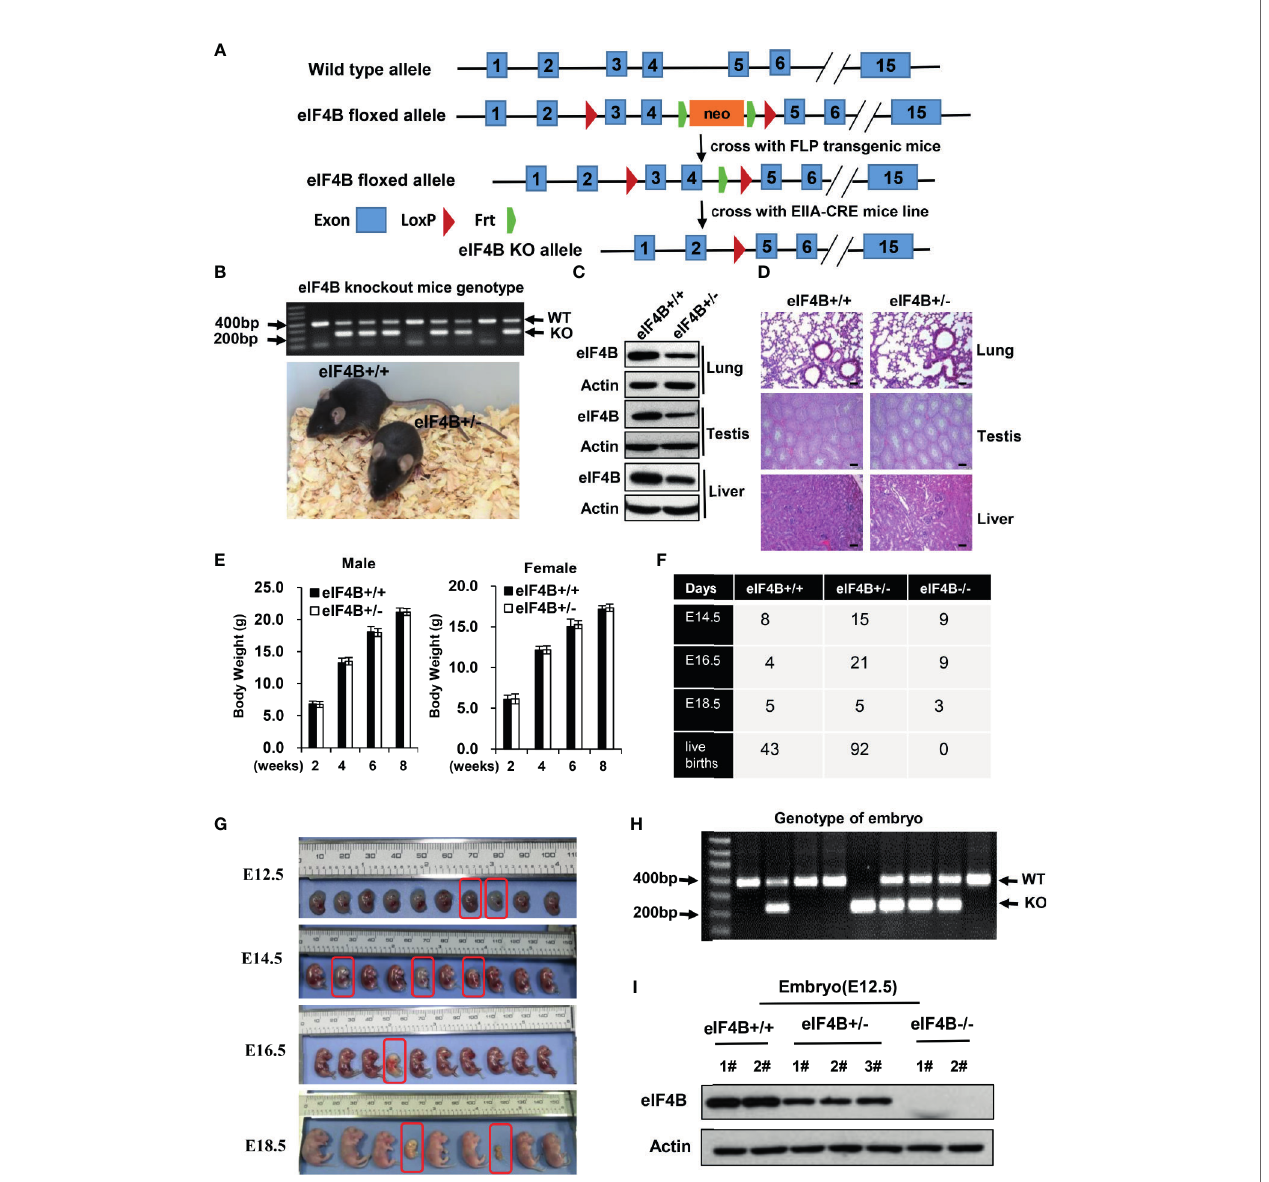
FIGURE 1 | Knockout of eIF4B leads to mouse embryonic lethality. (A) Schematic representation of the targeted eIF4B locus. Exons 3 and 4 are targeted and fl anked by two LoxP sits upon Frt- fl anked neomycin cassette. (B) The genotypes and representative images of eIF4B +/- mice and their eIF4B +/+ littermates. (C) Protein levels of eIF4B in the indicated tissues of eIF4B +/- mice and their eIF4B +/+ littermates were detected by Western blotting. (D) Representative micrographs of the indicated organs stained with hematoxylin and eosin (HE) from eIF4B +/- mice and their eIF4B +/+ littermates. Scale bars, 100 µm. (E) Comparing the average weights of eIF4B +/- mice and their eIF4B +/+ littermates within two months of age (n = 4-7 per genotype for each group). Data are represented as mean ± SD. (F) Statistics of offspring derived from mating eIF4B +/- female and male mice. (G) Gross images of E12.5, E14.5, E16.5, and E18.5 embryos derived from mating eIF4B +/- female and male mice. (H) Representative genotypes of embryos by PCR. (I) Protein levels of eIF4B in embryos were detected by Western